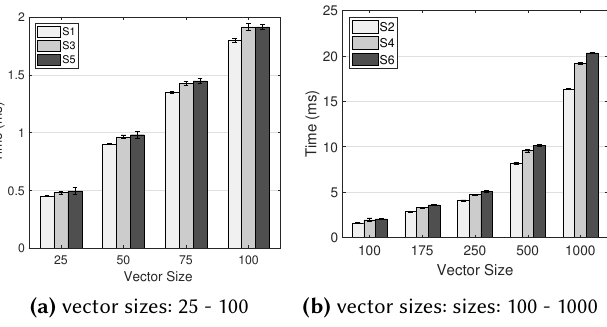
Figure 10. The time spent on verifying the model of different sizes. We run this experiment in each VM 100 times and calculate the mean and standard deviation of the execution time. From the experiments, we made the following observations across different infrastructures. First, as illustrated in Figure 9 and Figure 10, the time spent on initializing and verifying the model is nearly linear to the sizes of vectors. All three infrastructures show nearly similar timing statistics for model initialization and verification. Second, since the online component of VERDICT, the